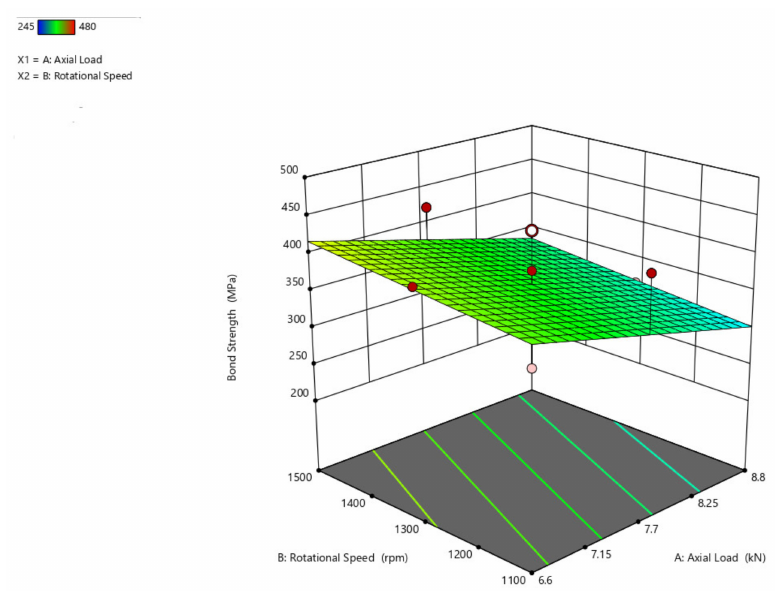
Figure 11. Interaction plot of axial load and rotational speed on bond strength (B s ).